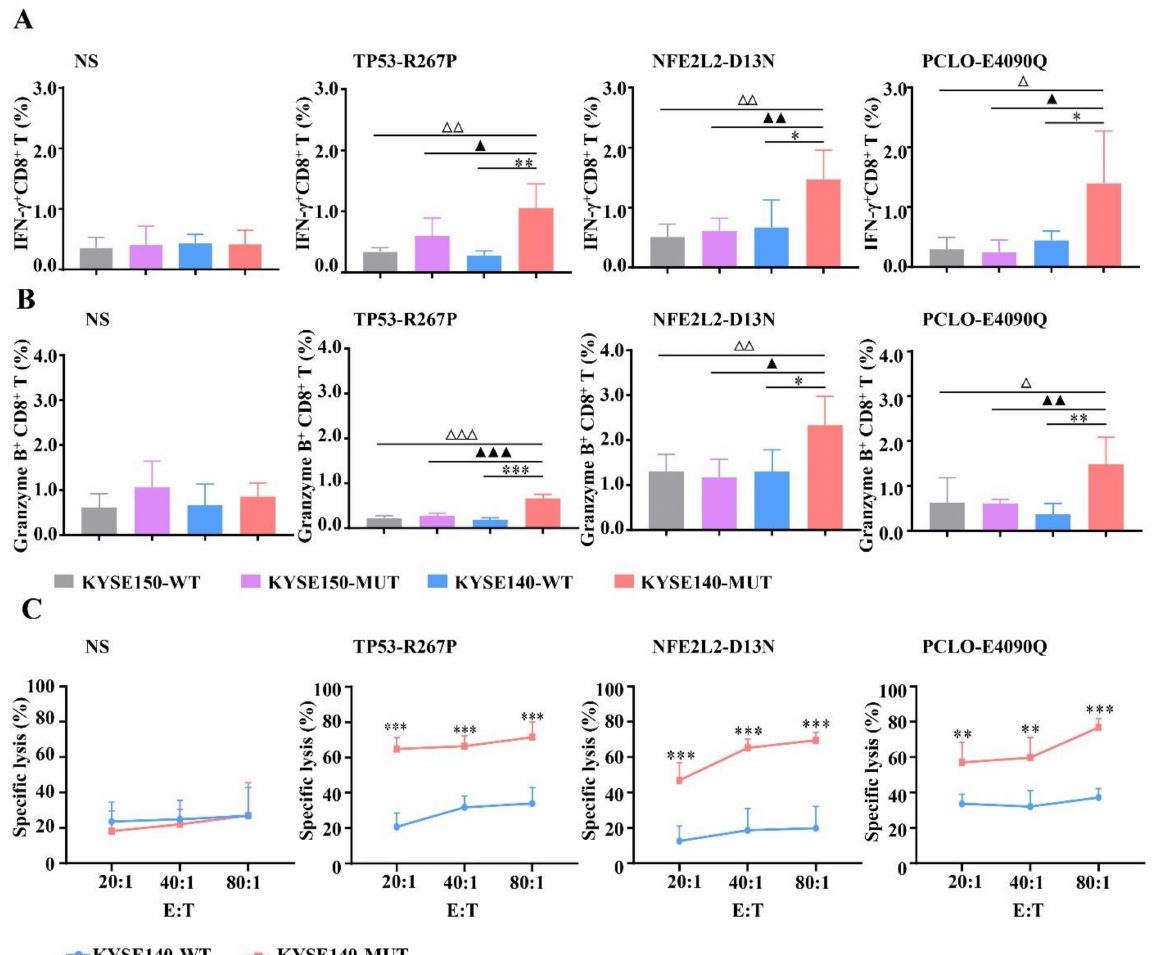
Figure 3. MUT peptide-specific and HLA-A2-restricted CTL responses in HLA-A2.1/K b transgenic mice. An amount of 100 µ g/mouse TP53-R267P, NFE2L2-D13N, PCLO-E4090Q, or normal saline (NS) was respectively injected s.c. at the end of the tail (n = 5 per group) with CpG ODN 1826 (30 µ g/mouse) once a week for three weeks. Then the spleen lymphocytes were re-stimulated with MUT peptides and co-cultured with respective target cells to detect the CTL response via IFN- γ secretion and granzyme B expression in the intracellular cytokine assay ( A , B ) and cytotoxicity assay ( C ). Transfected cells KYSE140-WT (HLA-A2 + , MUT peptide − ), KYSE140-MUT (HLA-A2 + , MUT peptide + ), KYSE150-WT (HLA-A2 − , MUT peptide − ), and KYSE150-MUT (HLA-A2 − , MUT peptide + ) were served as stimulator cells and target cells. Statistical significance was determined by Student’s t -test. In IFN- γ secretion and granzyme B expression assay, * p < 0.05, ** p < 0.01, *** p < 0.001 represented the significance of KYSE140-MUT group versus KYSE140-WT group;